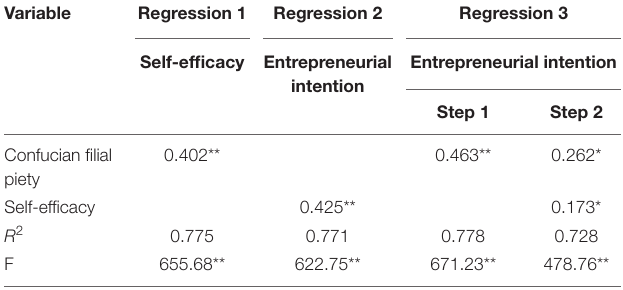
TABLE 7 | Mediation role of self-efficacy.